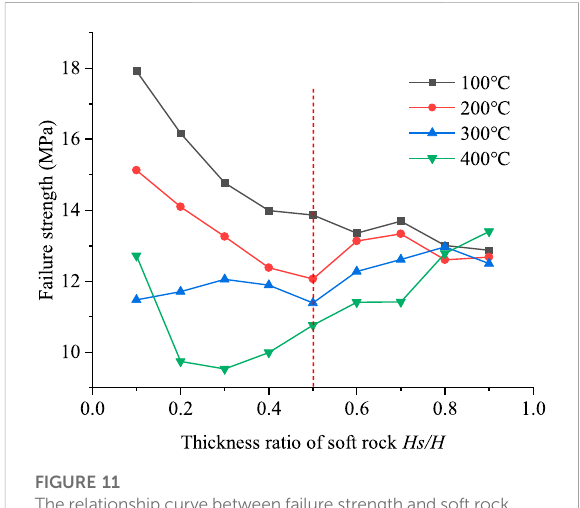
FIGURE 11 The relationship curve between failure strength and soft rock thickness ratio ( H s /H ) under different loading